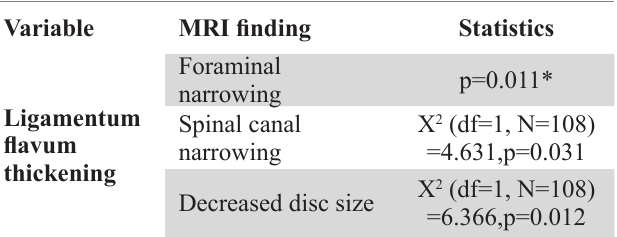
Table 3. Associations between ligamentum flavum thickening and MRI findings Variable